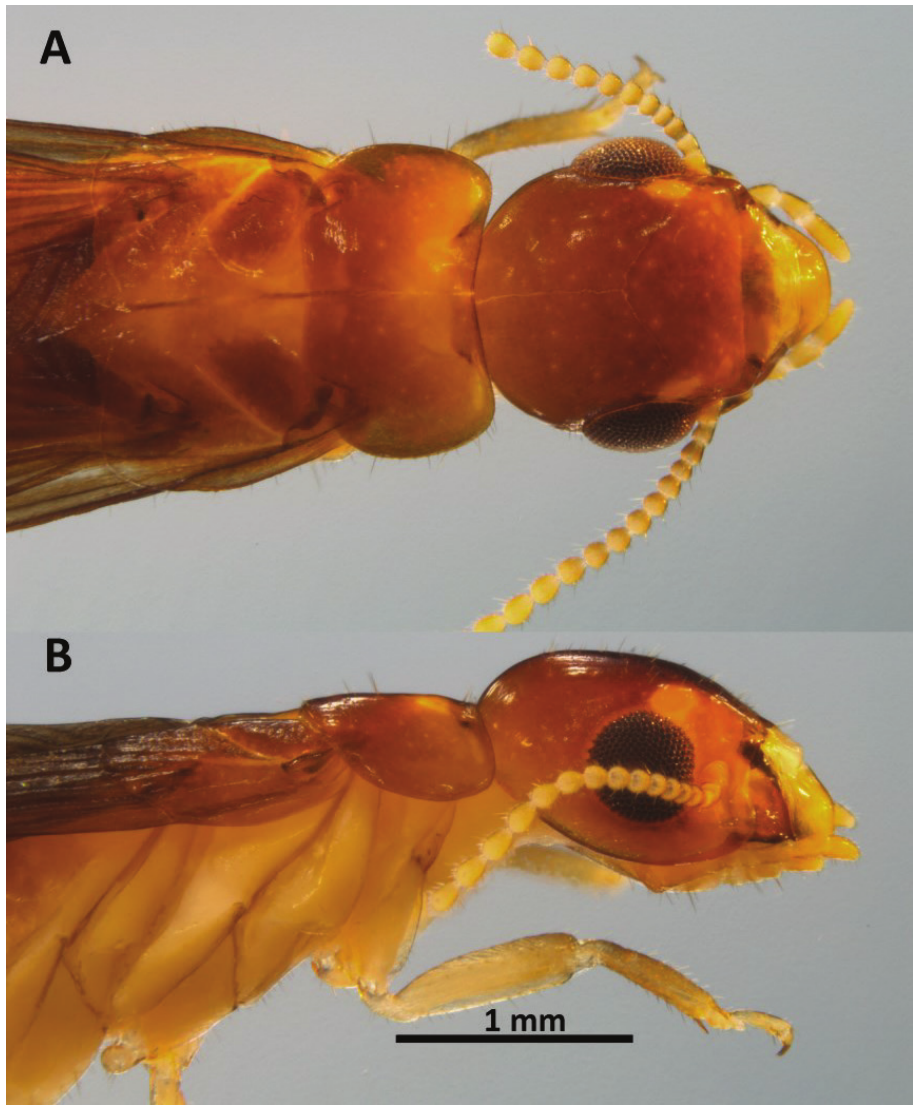
Figure 5. Head and thorax of Neotermes agilis imago . A Dorsal and B lateral views.